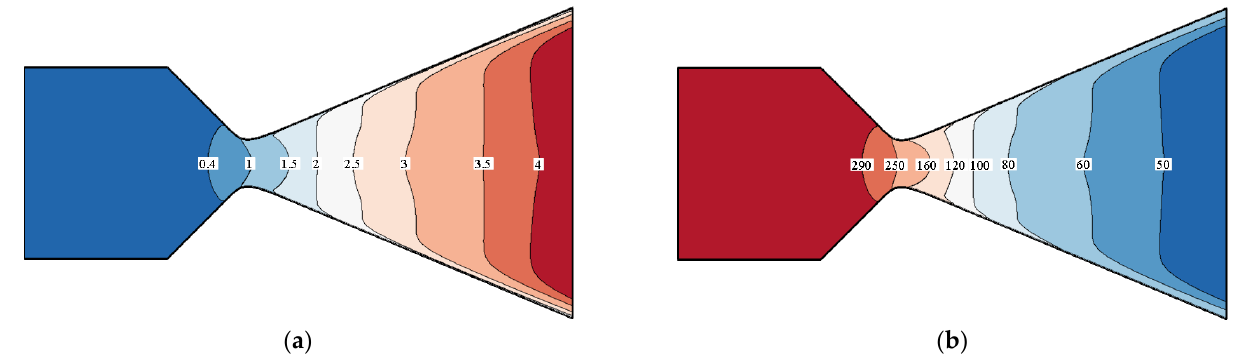
Figure 4. Isolines of Mach number and gas temperature in a fully expanded micronozzle: ( a ) Mach number; ( b ) gas temperature (K).